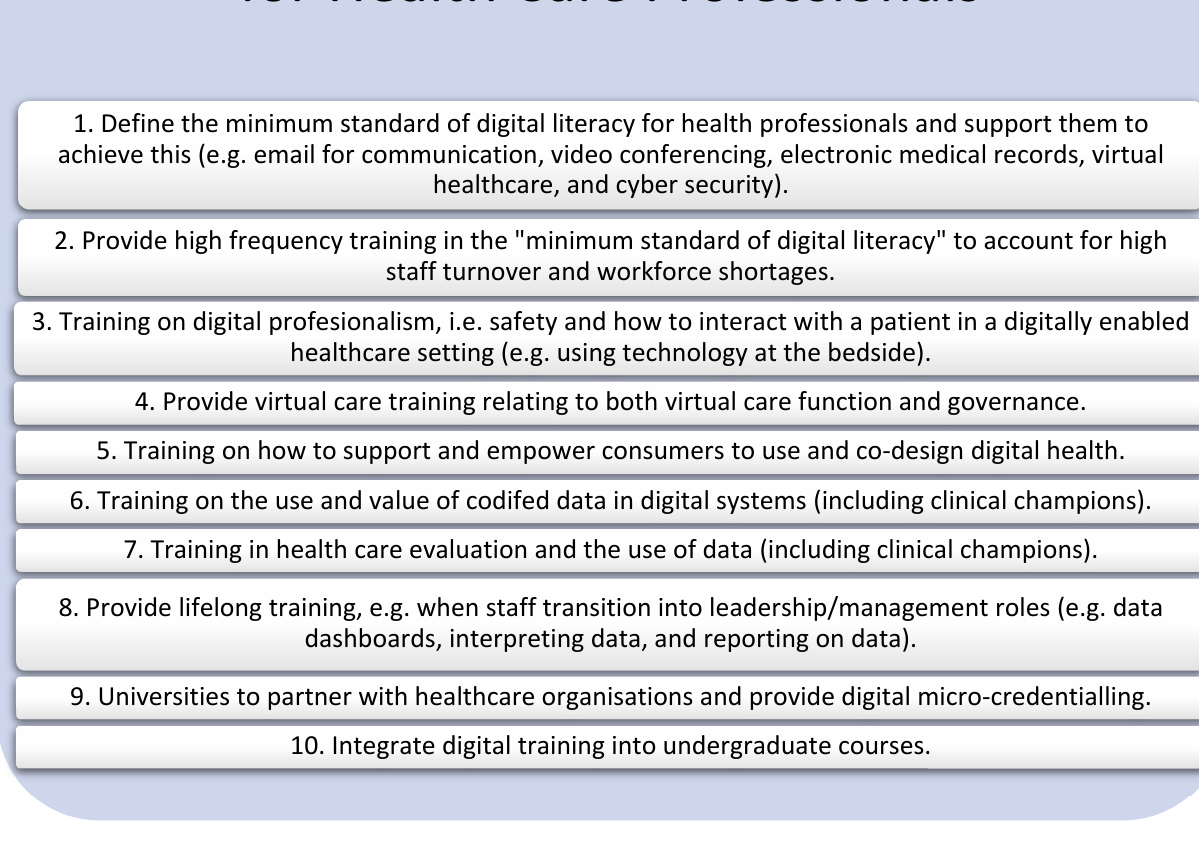
Figure 4. Strategies to improve the digital literacy of healthcare professionals.